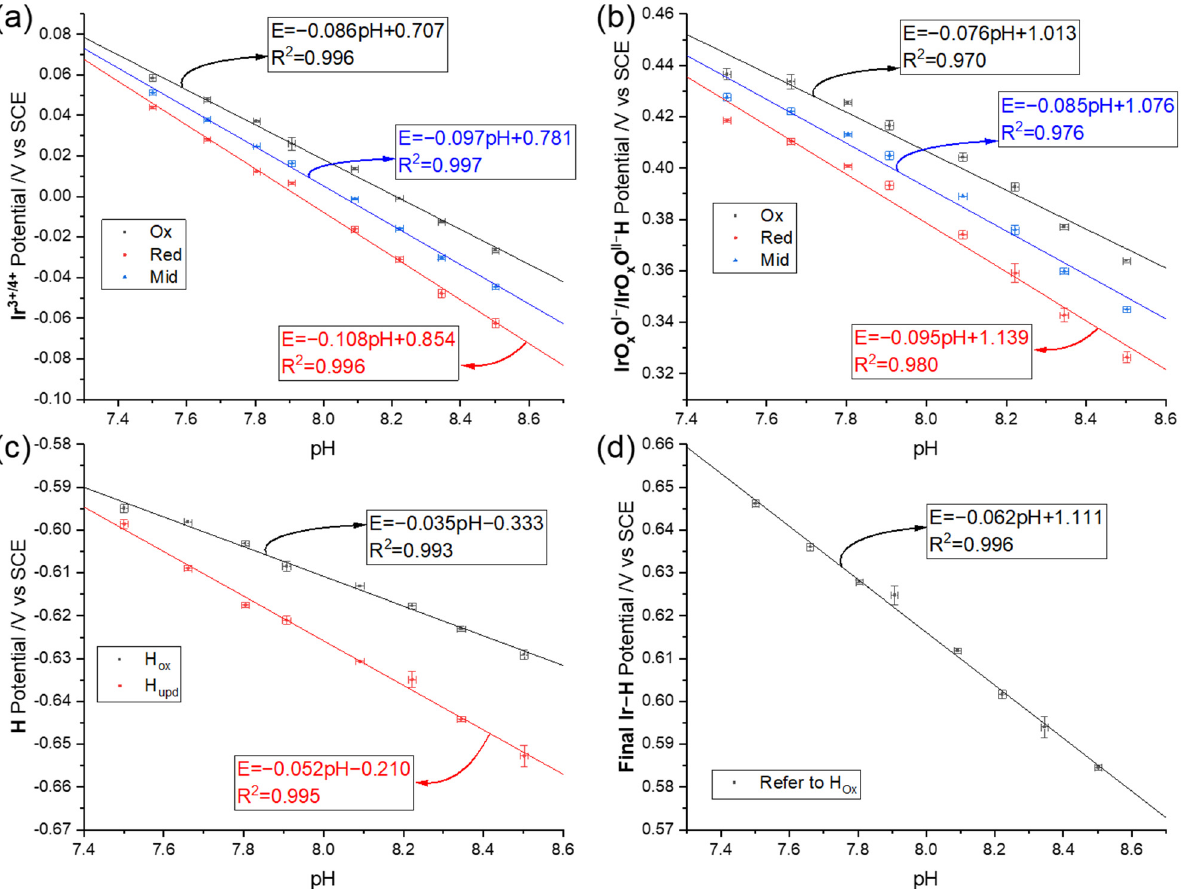
Figure 7. Plots of oxidation (black dots), reduction (red dots) peak, and midpoint (blue dots) potentials against pH value with the latter read from a pH meter (defined using total hydrogen ion scale) ( a ) Ir III/IV ( b ) IrO x O I − /IrO x O II − H ( c ) H upd /H ox and ( d ) Ir III/IV midpoints pH dependency referring to H ox ; x-axis error-bar is the uncertainty of pH measured by a pH